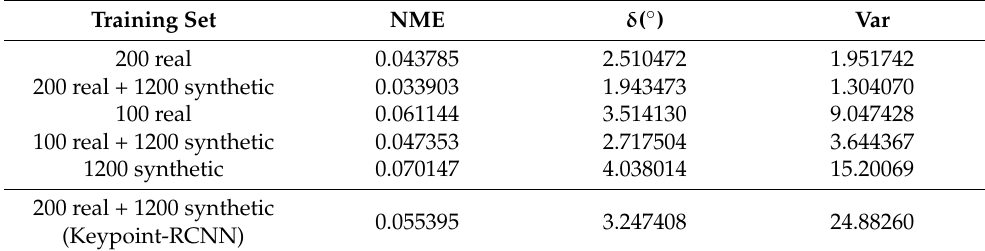
Table 6. Evaluation results of bolt and bolt corner point detection for the test